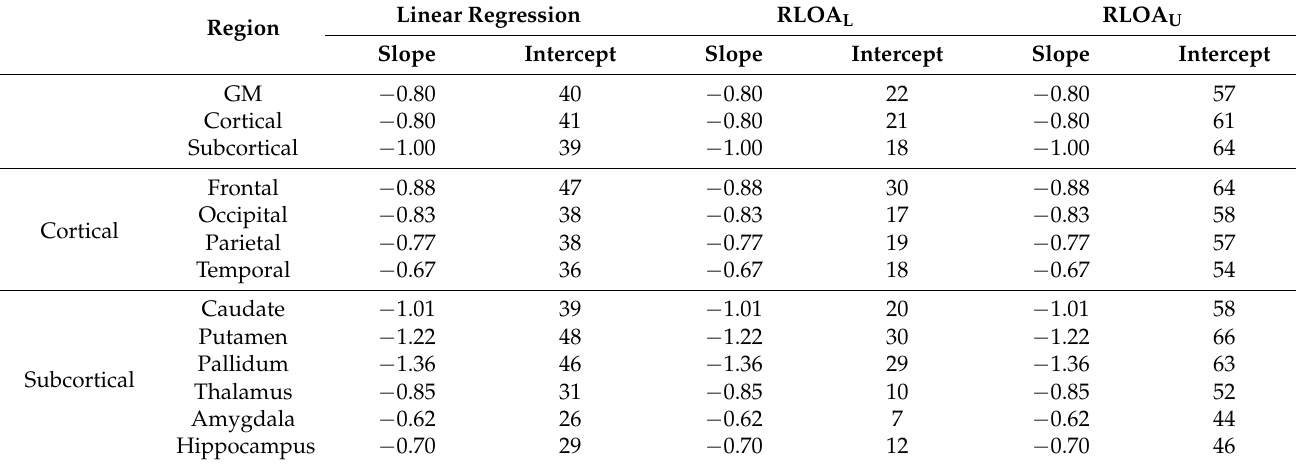
Table 3. Slope and intercept of the upper and lower regression-based limits of agreement (RLOA U and RLOA L , respec- tively) with slope and intercept from the regression analysis of the difference between CBF ASL –CBF PET on average of CBF ASL + CBF PET . A calculation example is given in Supplementary Document